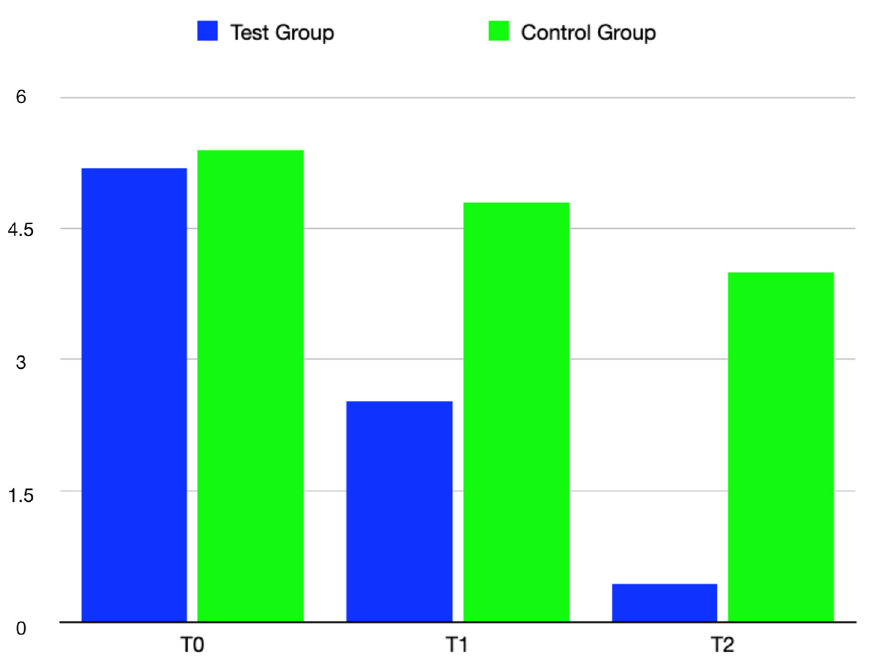
Figure 5. Graphic describing the mean VAS score reported by patients in the test group and control group at T0, T1 and T2. Table 1. Demographic variables and qualitative clinical variables at baseline (T0).